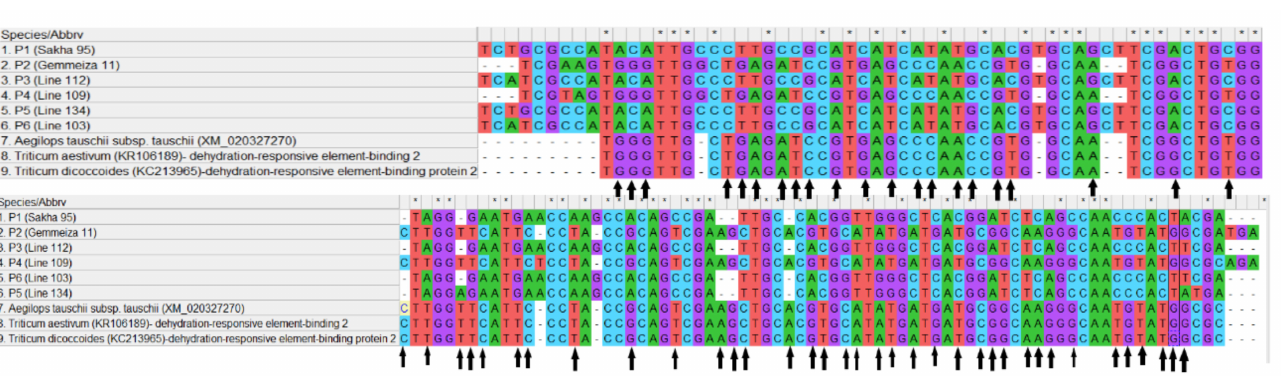
Figure 9. Single nucleotide polymorphisms (SNPs) in dehydrin gene between tested parental genotypes and other tolerant species ( Triticum aestivum , Triticum dicoccoides , and Aegilops tauschii